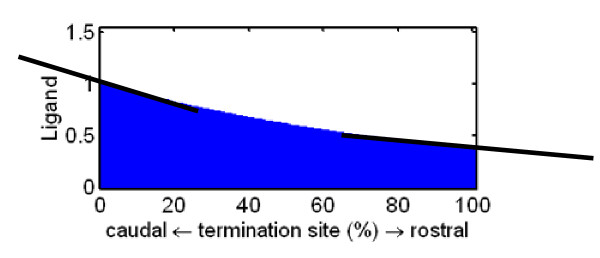
Reduced gradient of ligand in rostral SC may explain single-valued map there.